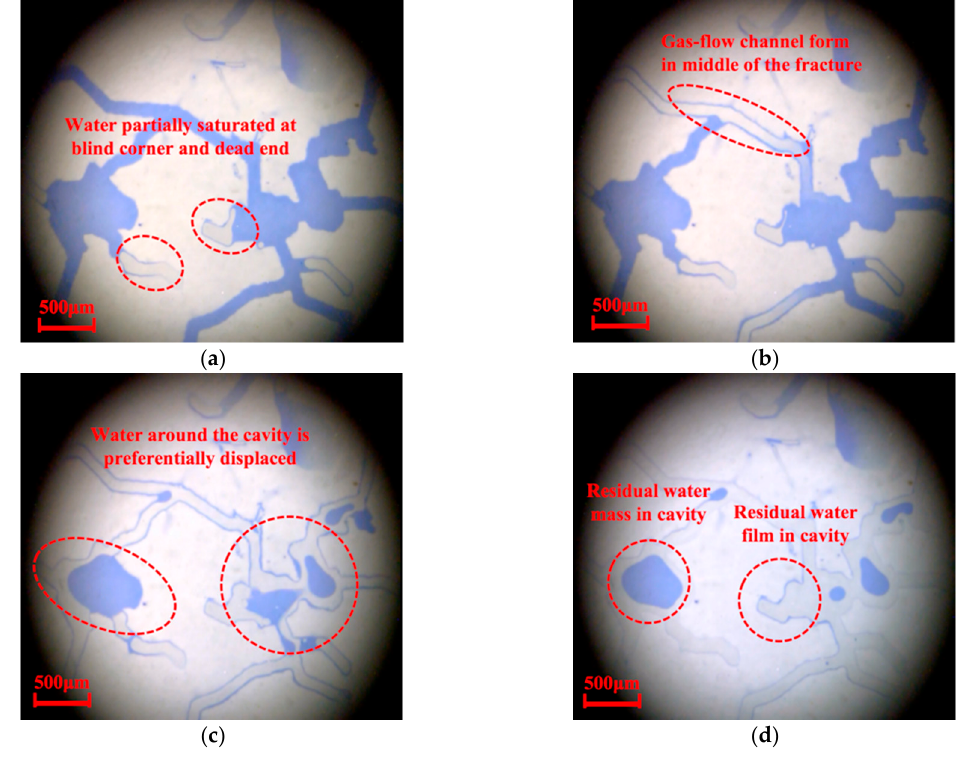
Figure 12. Gas-drive-water process of the fracture–cavity-type micromodel: ( a ) Initial stage; ( b ) Second stage; ( c ) Third stage; ( d ) Final